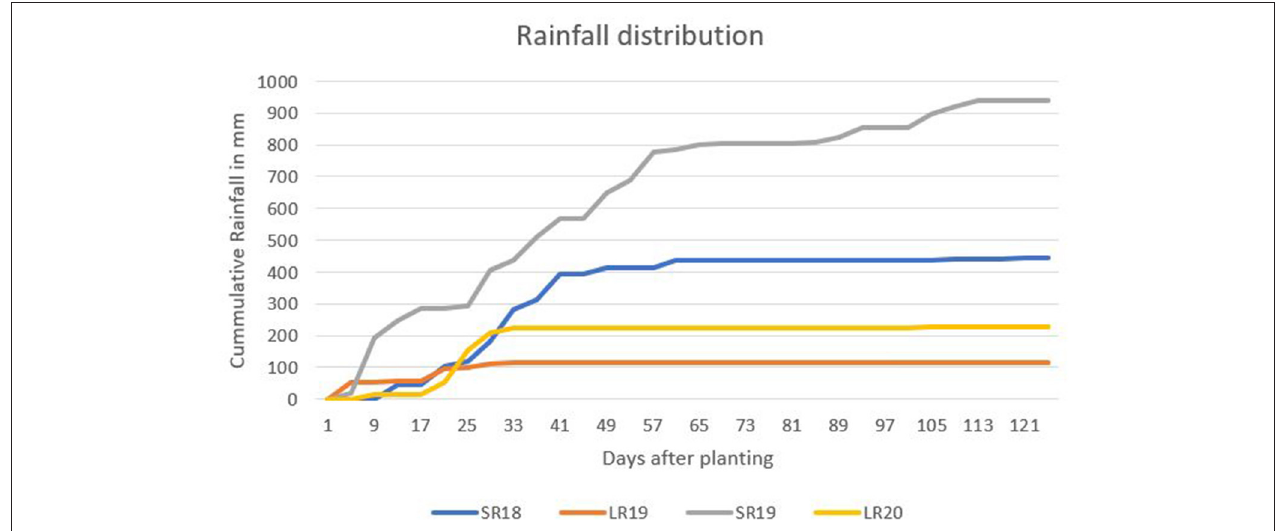
FIGURE 3 | Rainfall distribution from 2018 to 2020 for short rains 2018, long rains 2019, short rains 2019, and long rains 2020 seasons.